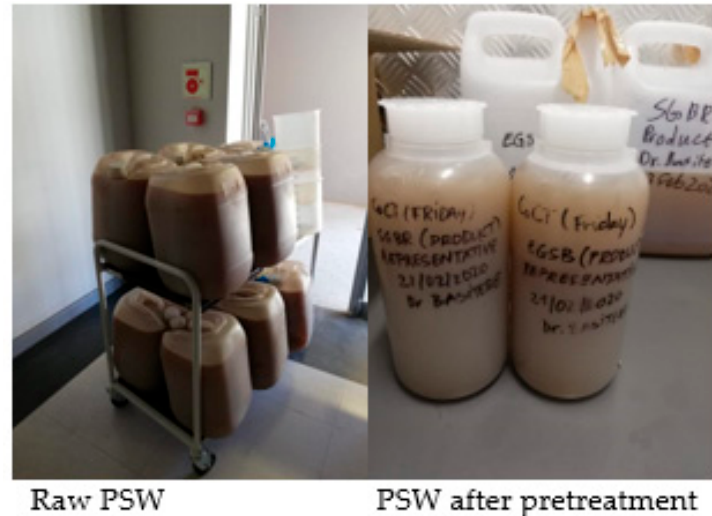
Figure 7. Photographs of the raw PSW in comparison to pre-treated PSW.